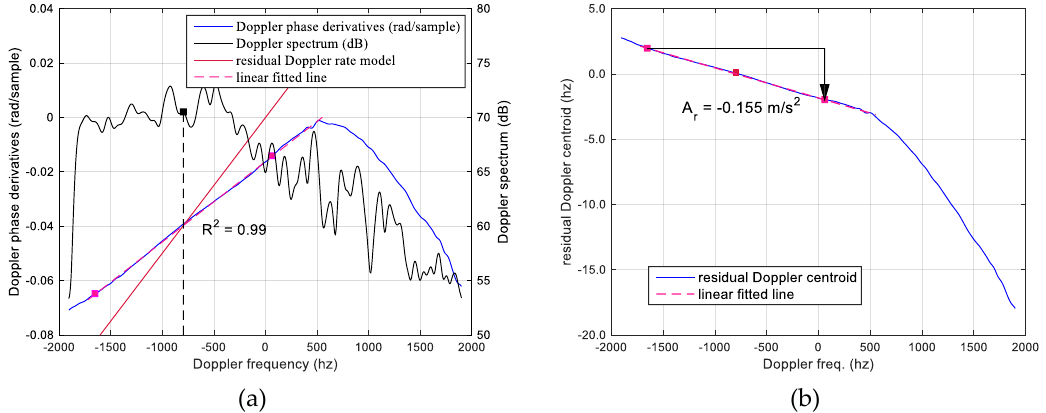
Figure 5. Across-track acceleration estimation for vehicle 3 in Figure 2: ( a ) Doppler spectrum (black solid line), residual Doppler rate model (red solid), and Doppler phase derivatives (blue solid lines). ( b ) An across-track acceleration of − 0.155 m / s 2 was obtained by the proposed method using 45% of full bandwidth around the Doppler centre frequency. The slope modelled from the residual Doppler rate (red solid line in ( a )) was significantly di ff erent from the slope of the best fitted line (pink dashed line in ( b )) to the Doppler phase